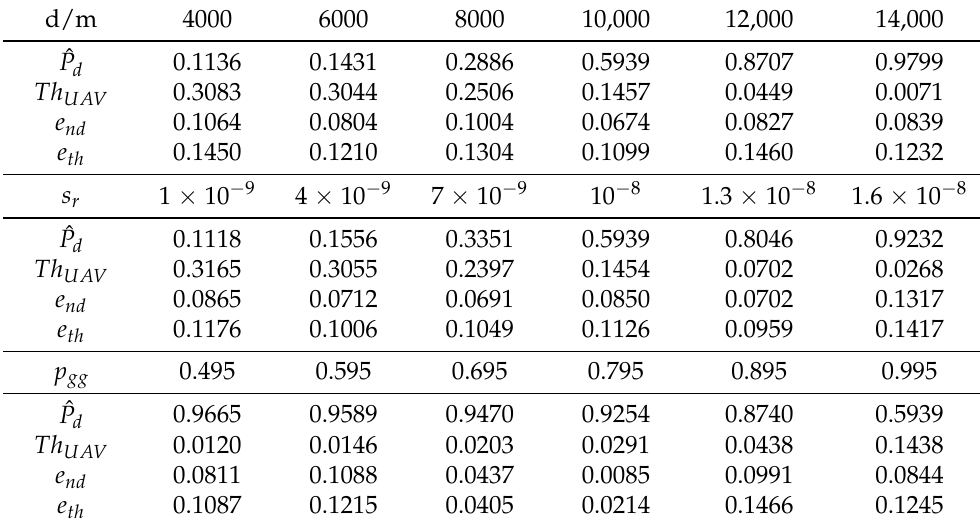
Table 5. Sensitivity table of performance to packet dropout rate